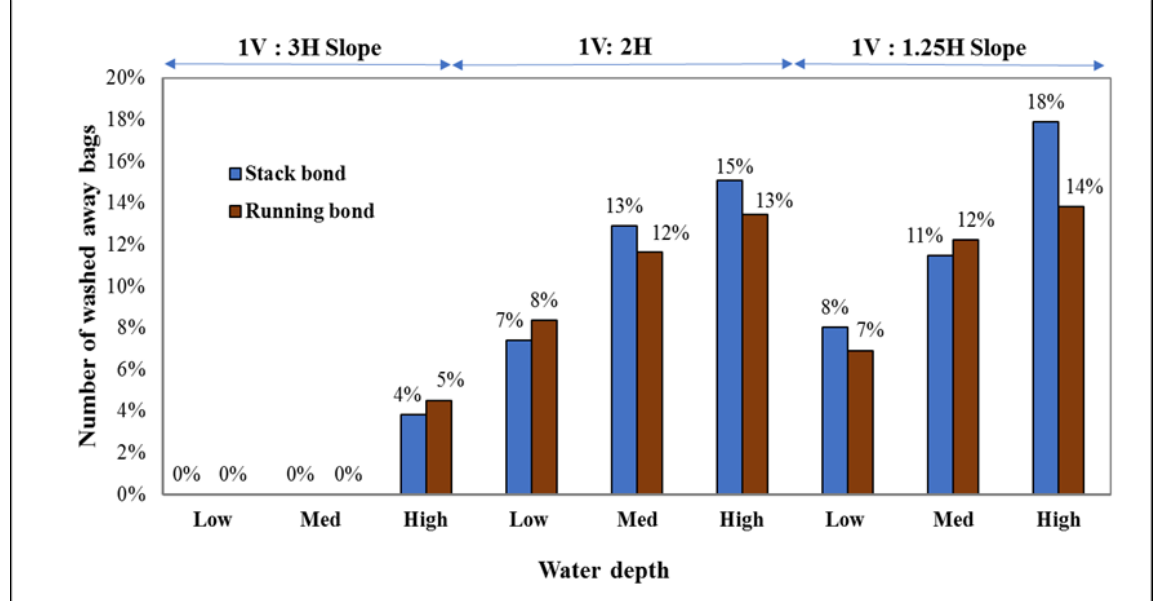
Figure 9. Average percentage of washed away bags at the end of each test.